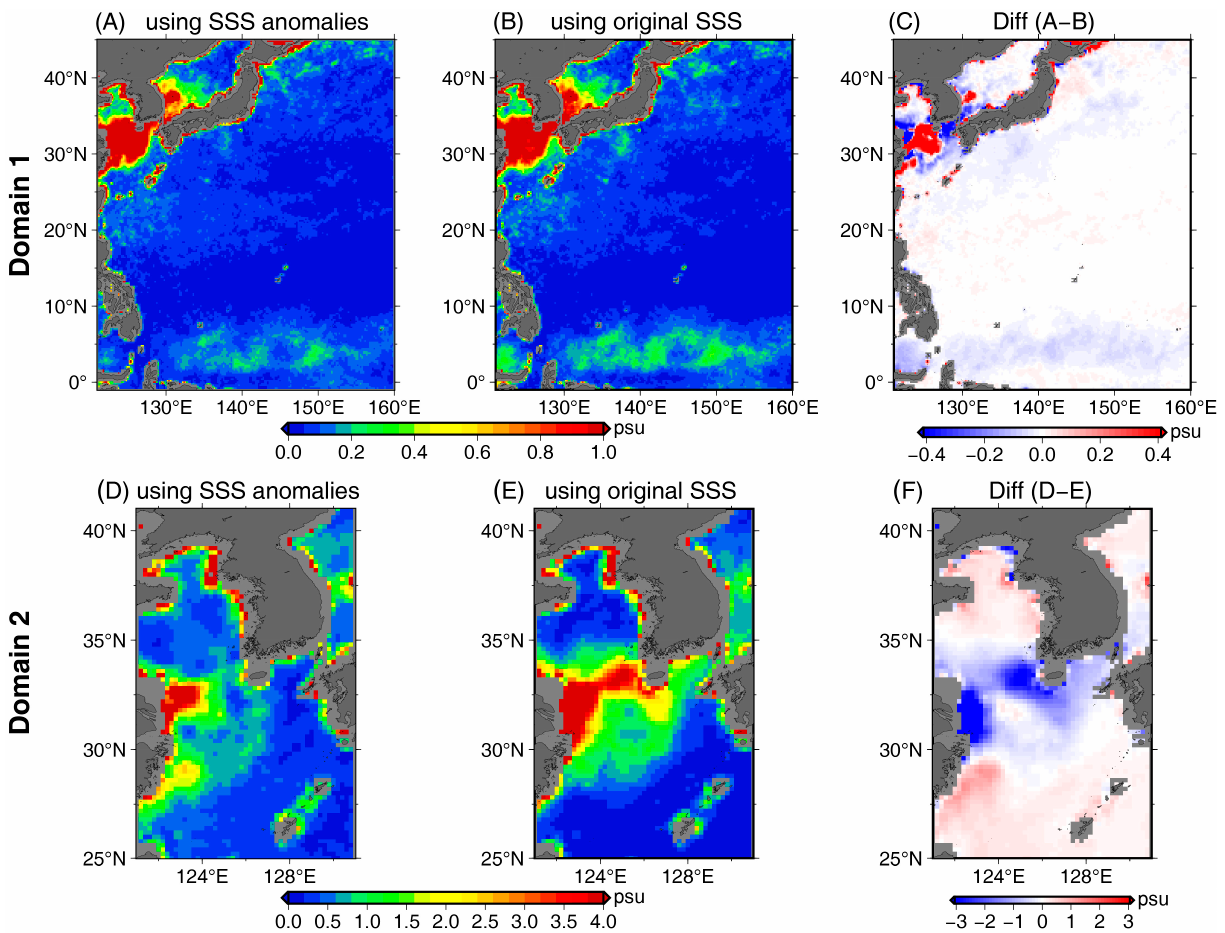
Figure 8. Standard errors of predicted SSSs in two domains based on models using ( A , D ) SSS anomalies and ( B , E ) original SSSs. The differences between the two standard errors are shown in panels ( C , F ), and the negative values show improvement. Note that the upper panels for Domain 1 use a smaller range in color shading for representing the improvement over the open seas.